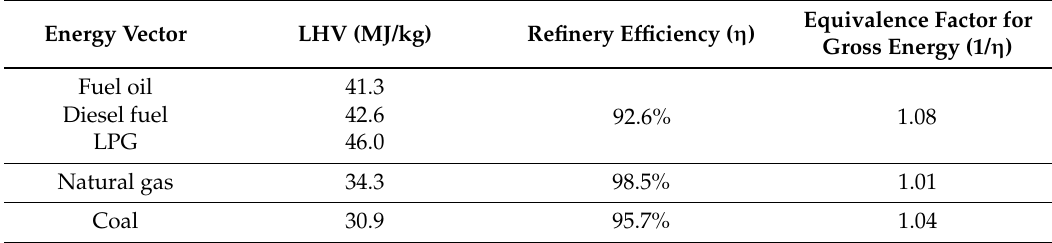
Table A1. Lower heating values and refinery efficiencies of fuel used in the food chain.